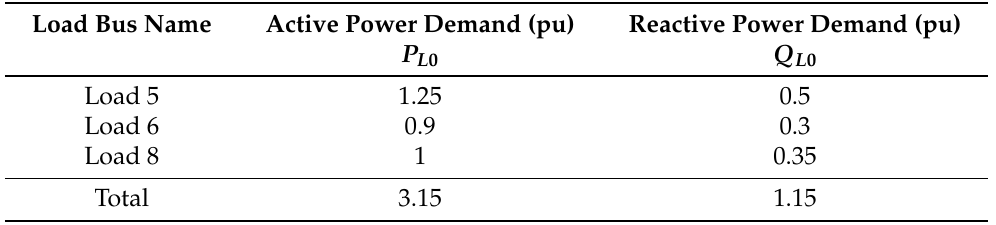
Table A1. Initial load bus data of the WSCC 9-bus test system for the simulations.